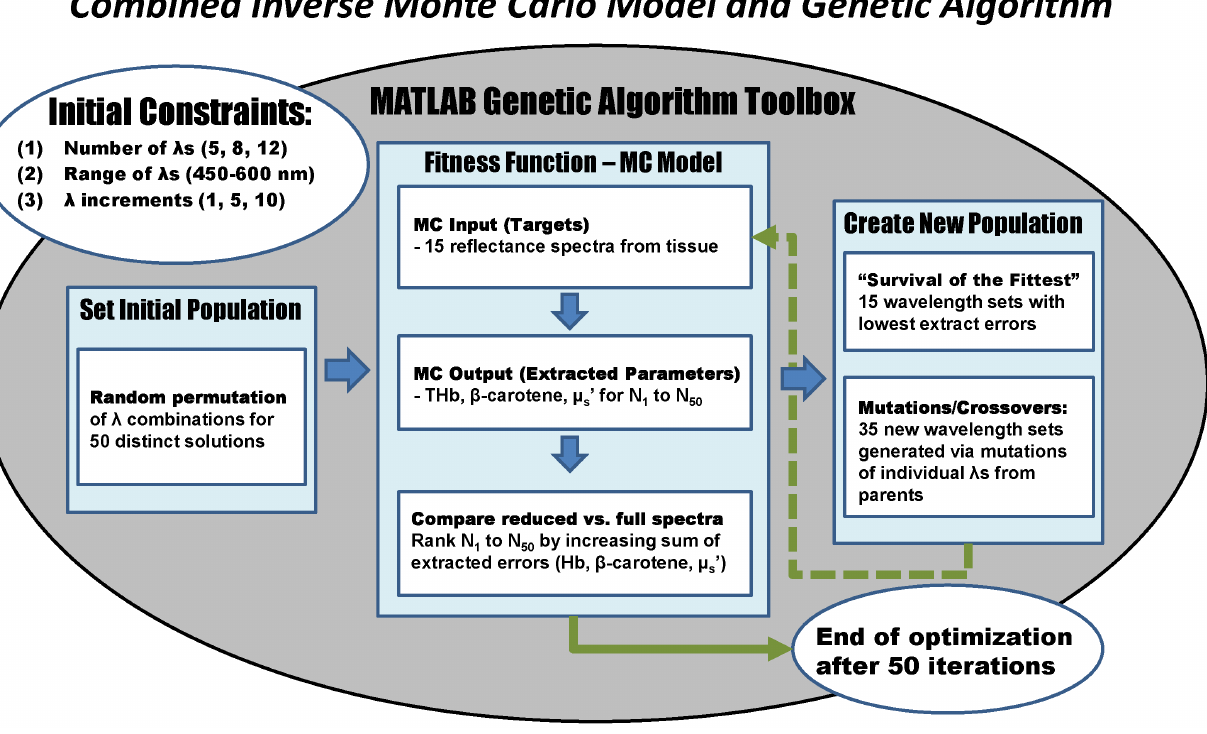
Figure 3. Diagram of combined Monte Carlo reflectance model and genetic algorithm. Diagram detailing the steps of selecting wavelengths for quantitative tissue spectroscopy using the genetic algorithm and inverse Monte Carlo model.